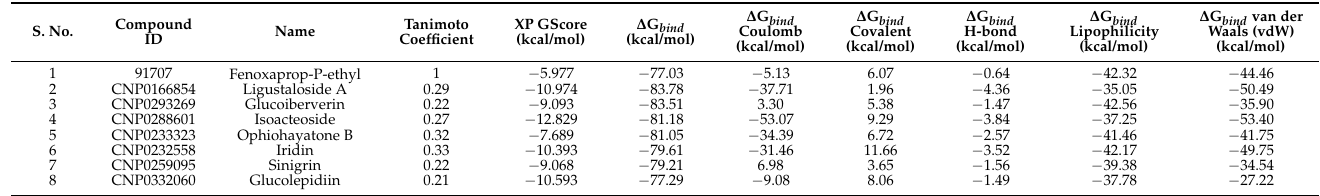
Table 1. Tanimoto coefficient, docking score, and binding free energy contributions of hit compounds.